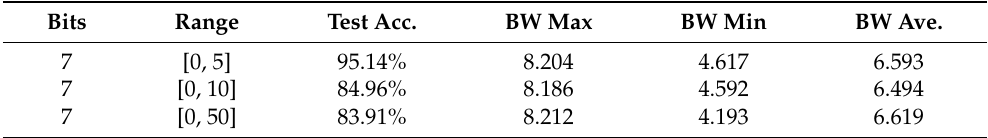
Table 3. The results of asynchronous attack, where BW stands for bandwidth (KB/s), and range is the input parameter of the random function called before